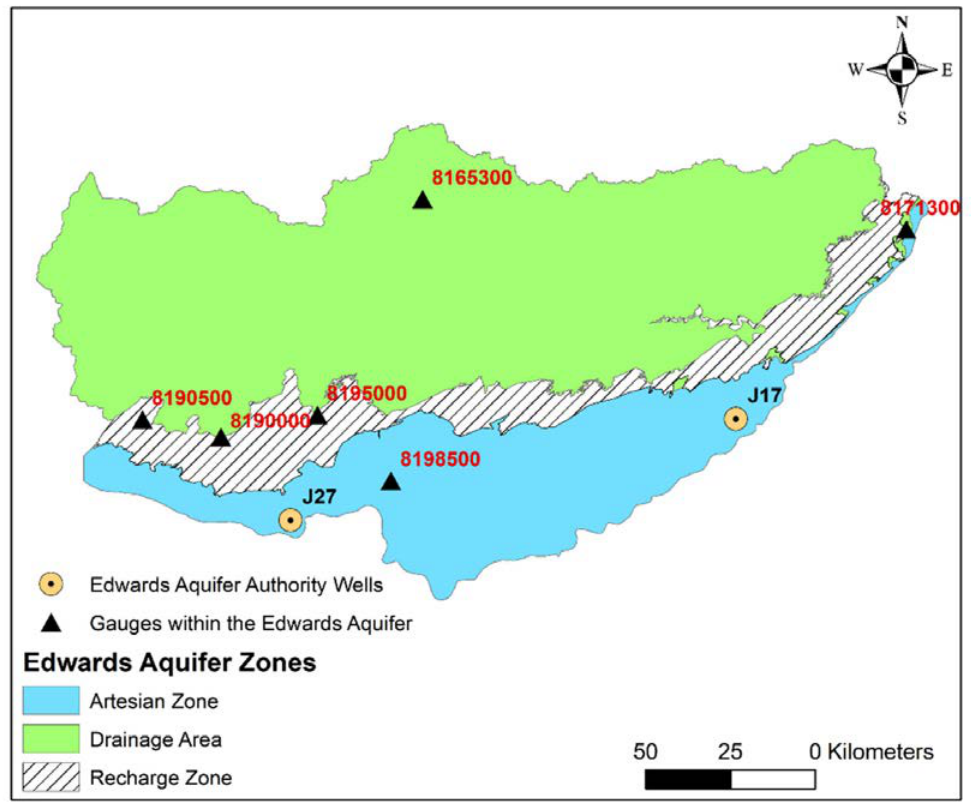
Figure 3. Location of six of the seven selected gage sites and the two Edwards Aquifer Authority (EAA) monitoring wells relative to the Edwards Aquifer recharge zone. The ArcGIS shapefiles for the aquifer zone maps were retrieved from the Edwards Aquifer Authority 2021a. The leading zeroes in the gage IDs have been